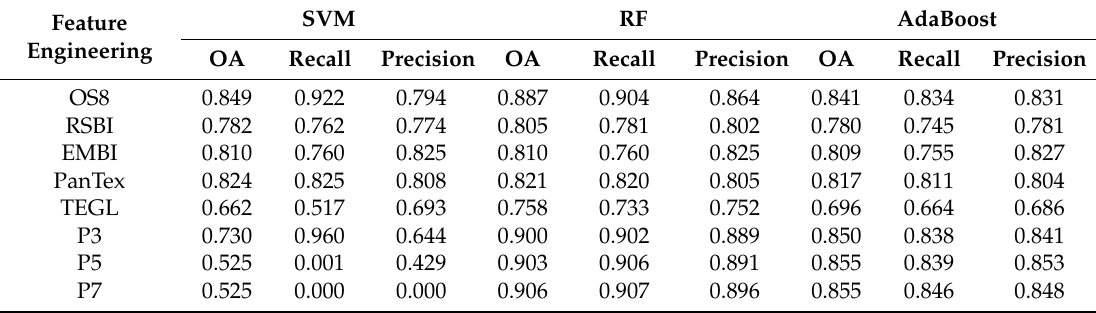
Table 5. Accuracy evaluation based on feature engineering.